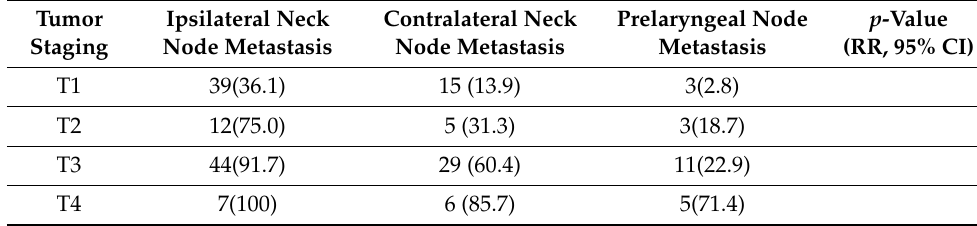
Table 2. Analysis of metastasis of cervical neck lymph nodes.